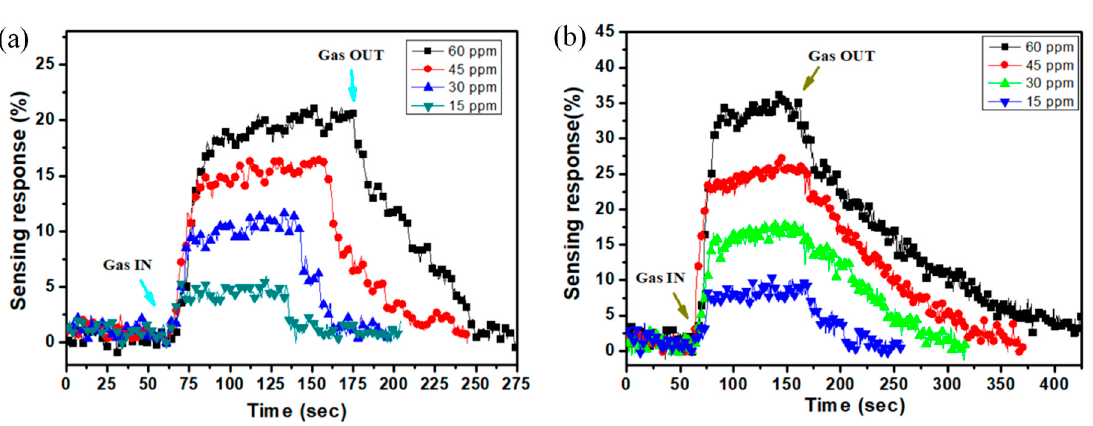
Figure 8. ( a ) Sensing response of ZnO sample sensor and ( b ) Au–ZnO sample sensor.